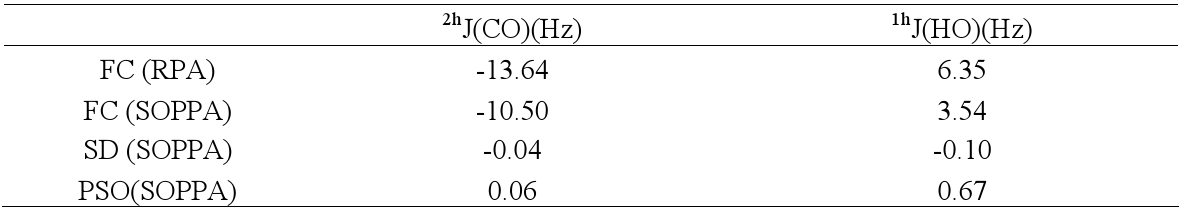
Table 1. 2h J(CO) and 1h J(HO) in system I calculated within the RPA and SOPPA